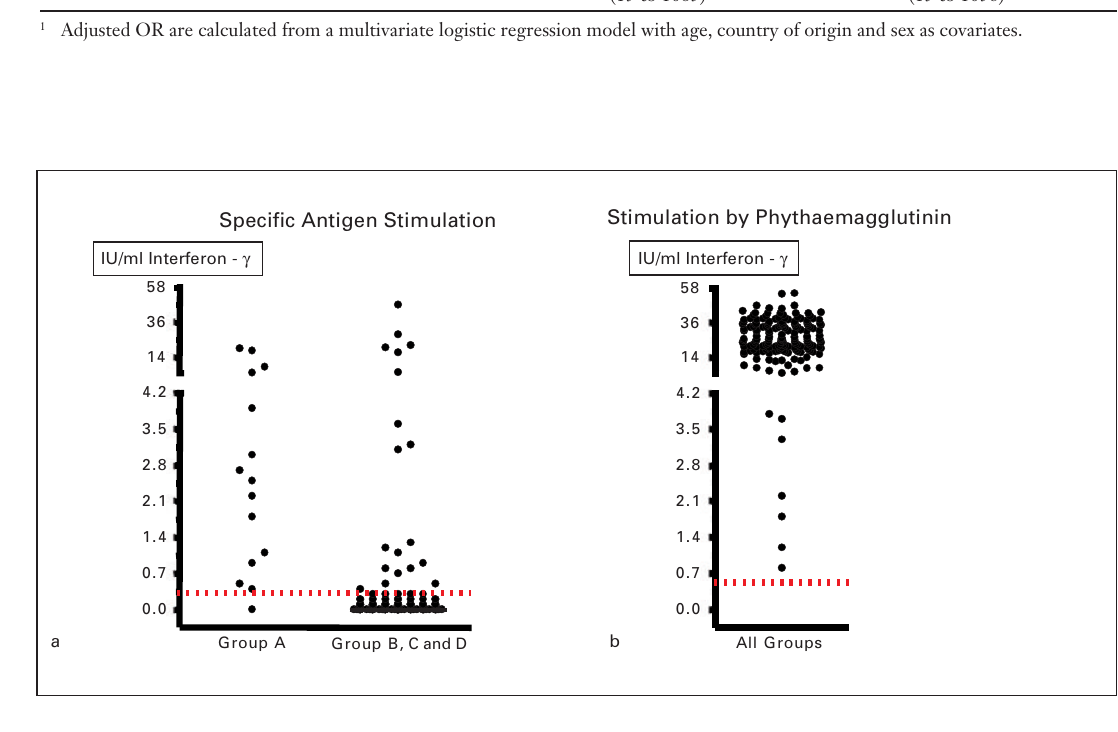
1 Adjusted OR are calculated from a multivariate logistic regression model with age, country of origin and sex as